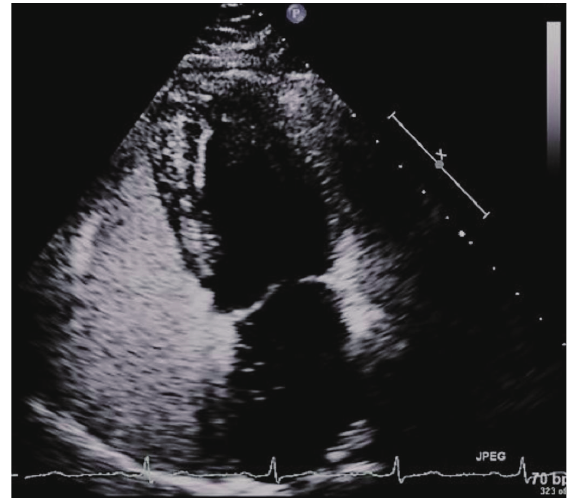
Figure 1 Microbubble contrast enhanced 2D echocardiogram. This microbubble contrast enhanced 2D echocardiogram shows opacification of the right atrium and right ventricle with saline microbubble contrast. Bubbles within the left atrium and ventricle, which in this case were present within 3 cardiac cycles, confirming the presence of an intracardiac shunt at the atrial level. The presence of bubbles within the left atrium after 3 cardiac cycles demonstrates the presence of an intrapulmonary